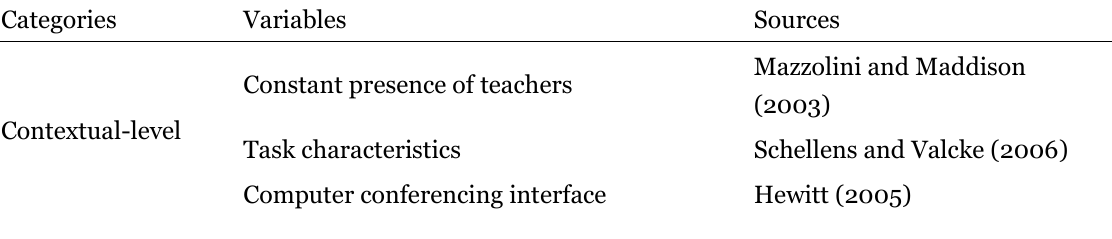
Factors Influencing Thread